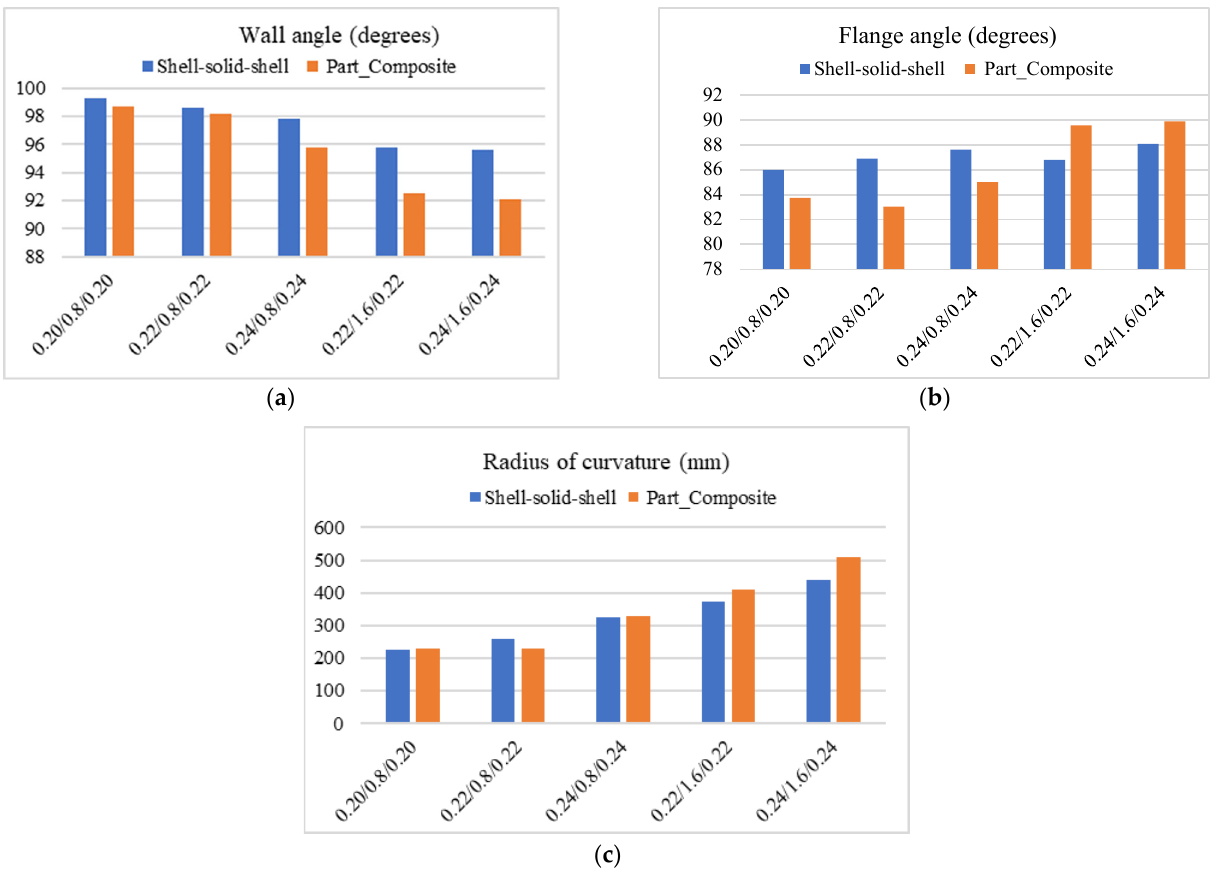
Figure 23. Comparison of springback with different modelling approach (shell-solid-shell and Part_Composite) for a 5 mm die/punch radius ( a ) Wall angle ( b ) Flange angle ( c ) Radius of curvature.